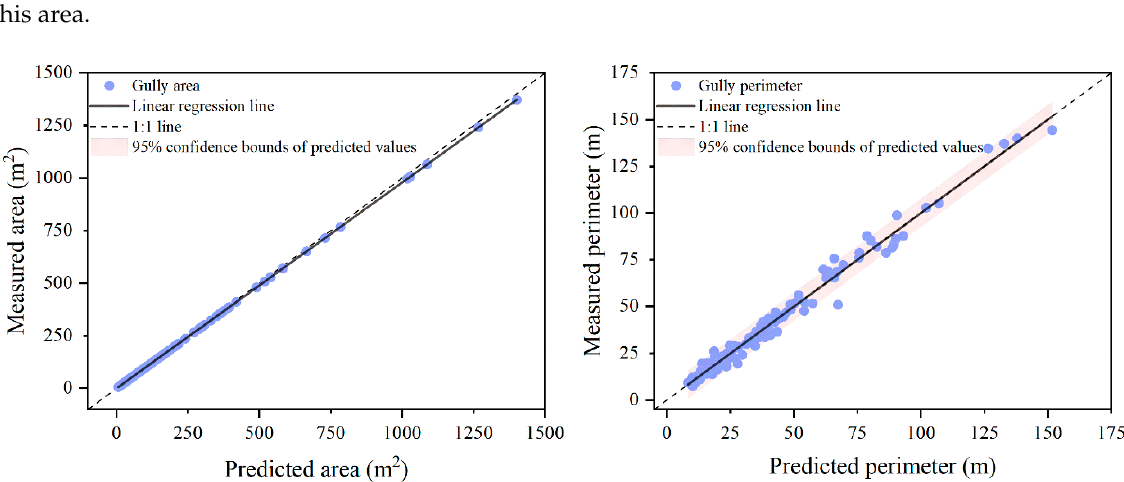
Figure 5. Comparison between the predicted and the measured gully area and between the predicted and the measured gully